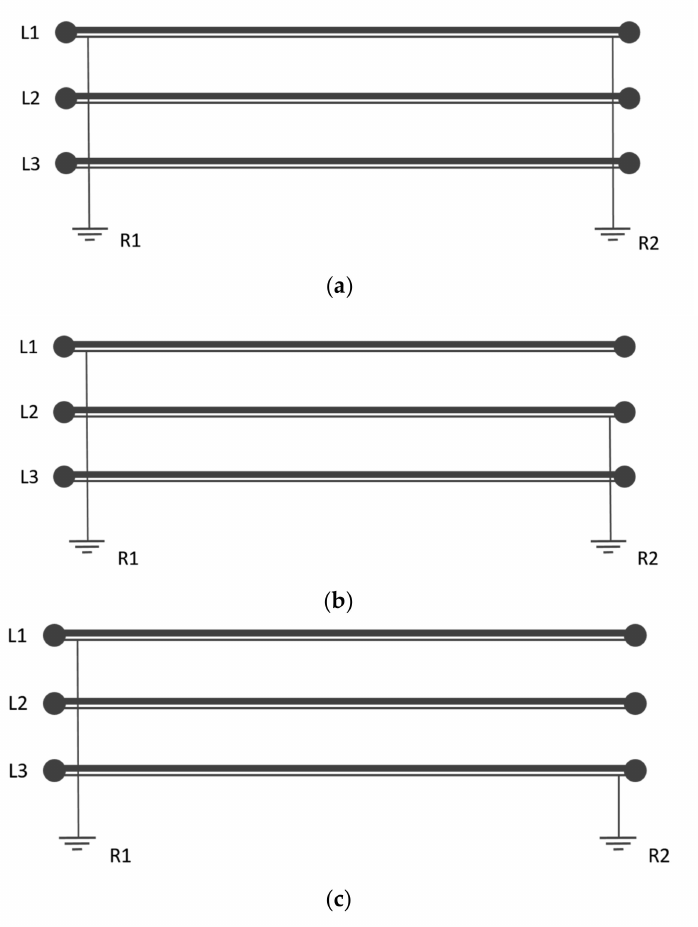
Figure 2. Cable screens grounding methods: ( a ) Both-ends bonding; ( b ) Both-ends bonding with one of the phases one-sidedly ungrounded; ( c ) Both-ends bonding with two of the phases one-sidedly